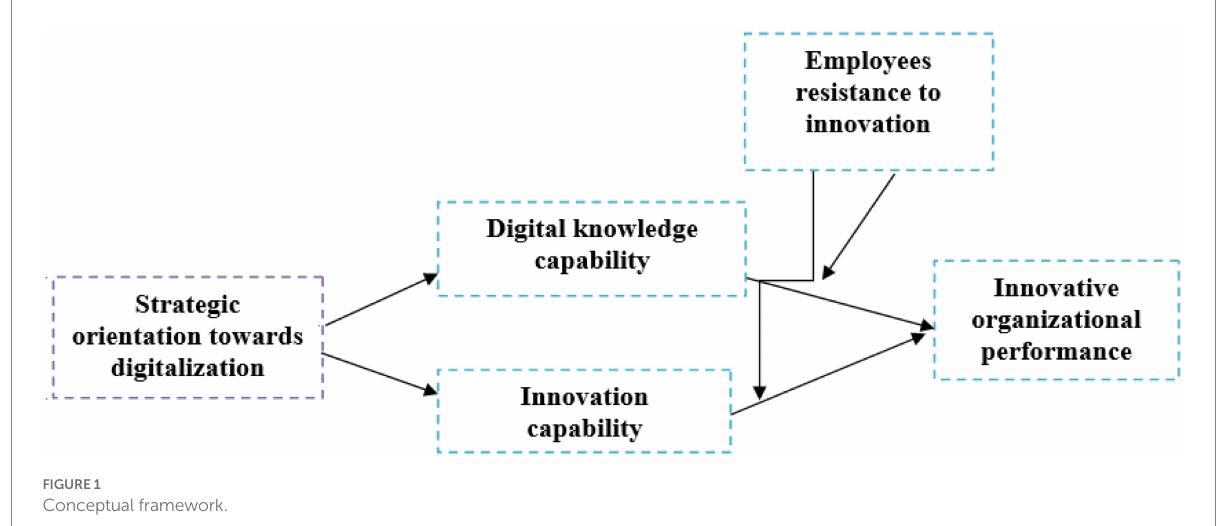
FIGURE 1 Conceptual